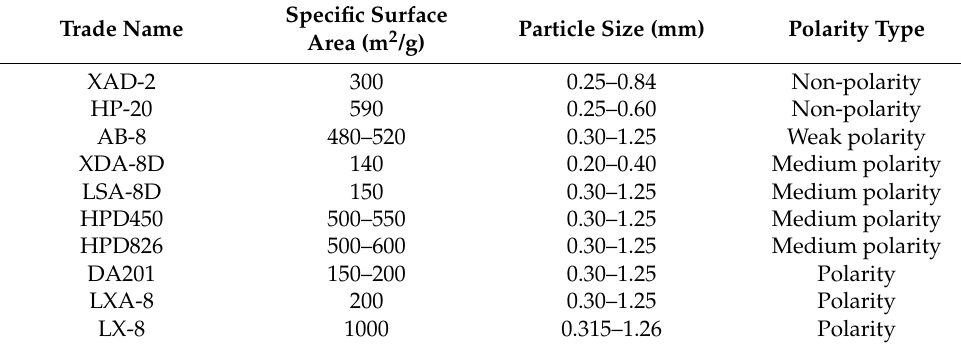
Table 1. Physical properties of the tested resins in this